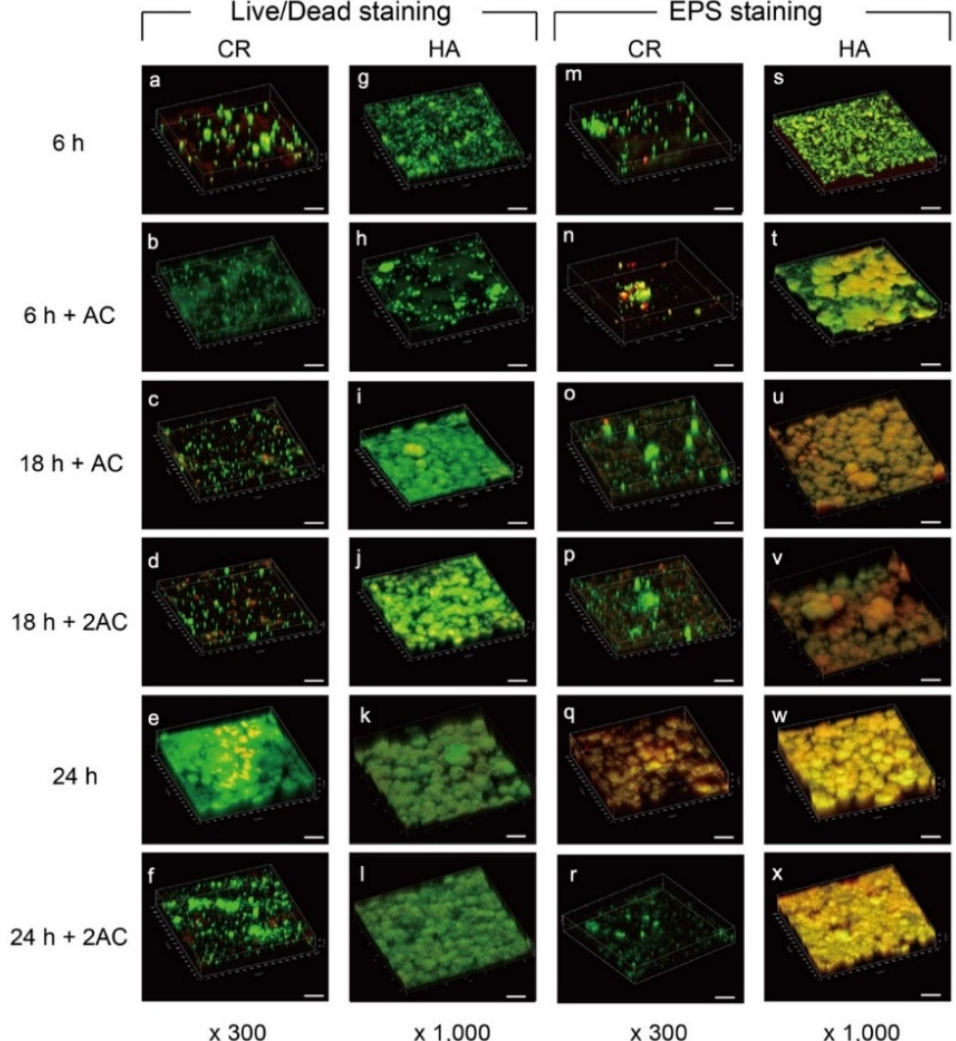
Figure 3. Representative 3-dimensional reconstructed images of S. mutans biofilm using Live/Dead ( a – l ) and SYTO9/rhodamine-B ( m – x ) staining. Live cells are stained green (SYTO9), and dead cells are stained red (propidium iodide). EPS staining was performed using SYTO9 for all bacteria and rhodamine-B for EPS (red). 6 h: 6 h of culture; 6 h + AC: A single exposure to 1M acetic acid (pH